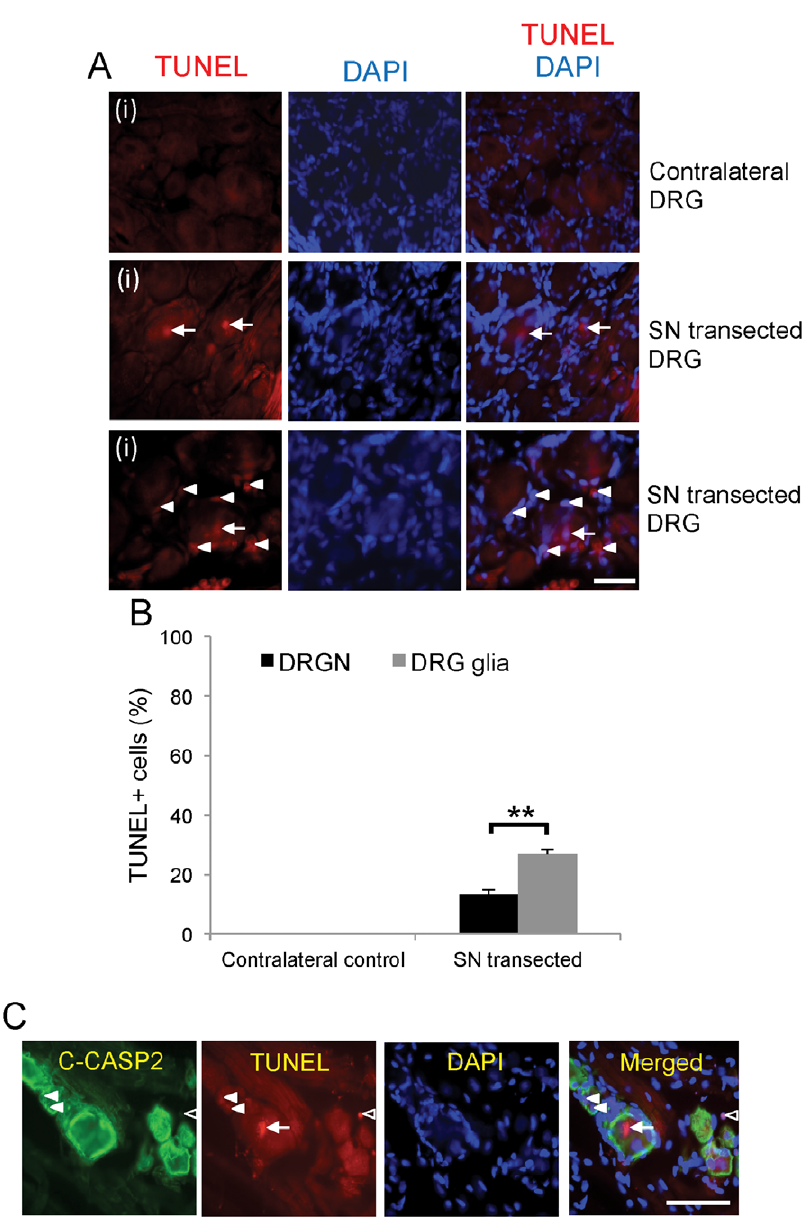
Figure 2. Apoptosis of DRGN and satellite cells at 1 month after SN transection. A , TUNEL staining in sections from contralateral control ( i ) and axotomised DRGN ( ii ) and ( iii ) (( ii ) shows 2 TUNEL + DRGN nuclei, while (iii) shows TUNEL + DRGN and DRG glia in an adjacent area)), 1 month after SN transection. DRGN (arrows) and satellite cell (arrowheads) nuclei were TUNEL + while contralateral DRGN and satellite cells were TUNEL 2 . B , Relative percentages of TUNEL + DRGN and DRG glia (satellite + Schwann cells) in ipsilateral and contralateral DRG after SN transection. C , Double labelling for TUNEL and C-CASP2 in DRGN (arrows), satellite cells (arrowheads) and Schwann cells in the DRG neuropil (open arrowheads). Scale bars in A – C =50 m m. **p , 0.001, ANOVA.